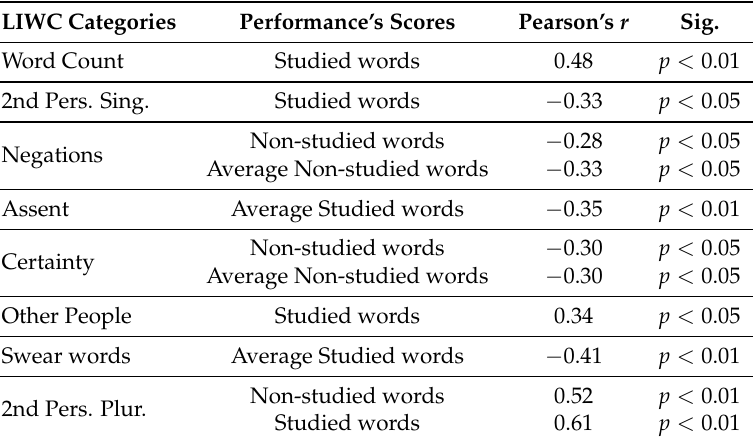
Table 5. Pearson’s r correlations between Linguistic Inquiry Word Count (LIWC) categories and subjects’ performance. With regard to the subjects’ performance, the studied words and non-studied words mean the total performance of the group, whilst the average values of the studied words and non-studied words represent the total performance divided by the group